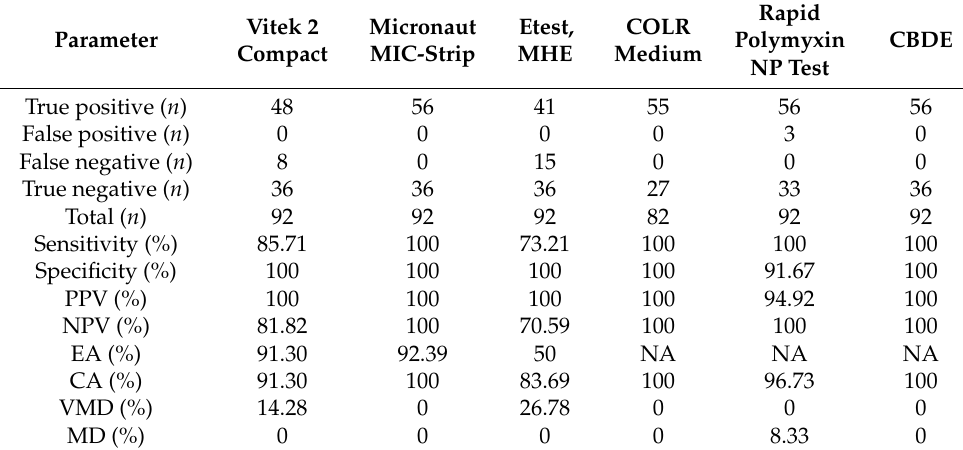
Table 2. Performance features of Vitek 2 Compact, Micronaut MIC-Strip, Etest, COLR medium, Rapid Polymyxin NP Test, and CBDE of all isolates according to the BMD.